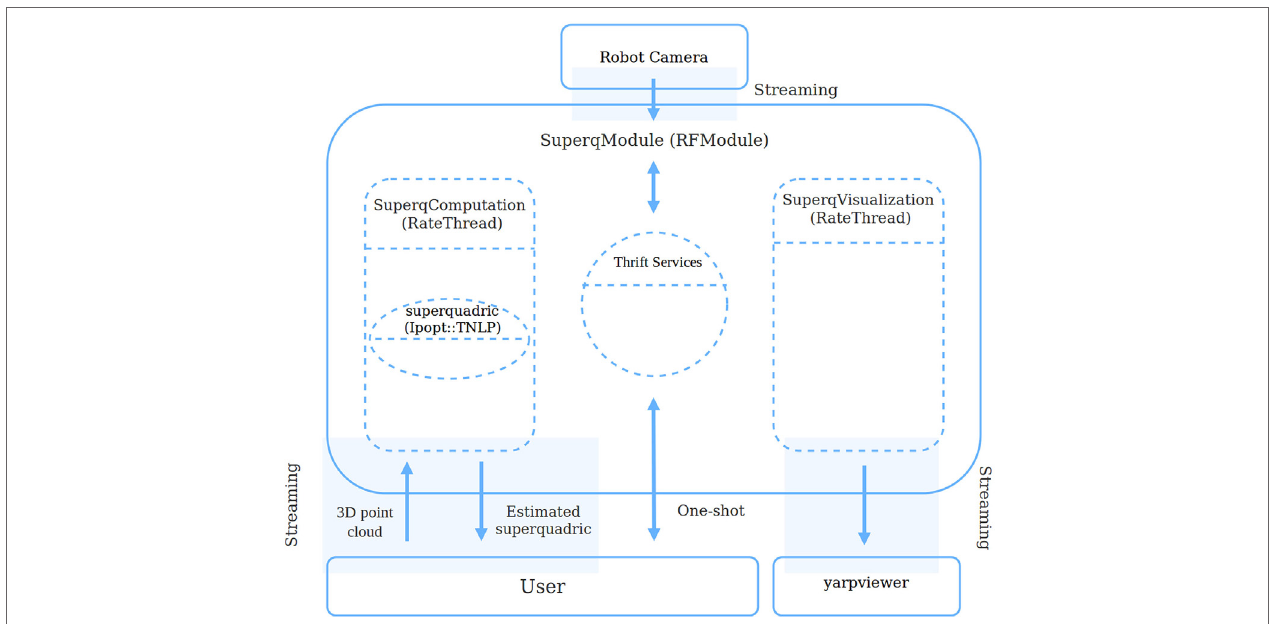
FIGURe 1 | Superquadric-model code structure. The class SuperqModule, derived from the YARP RFModule class, launches two threads, respectively for superquadric computation and visualization. The class provides some thrift services to the user for interacting with the module. More detail on the user box is provided in Section 3.3 and in Figure 2